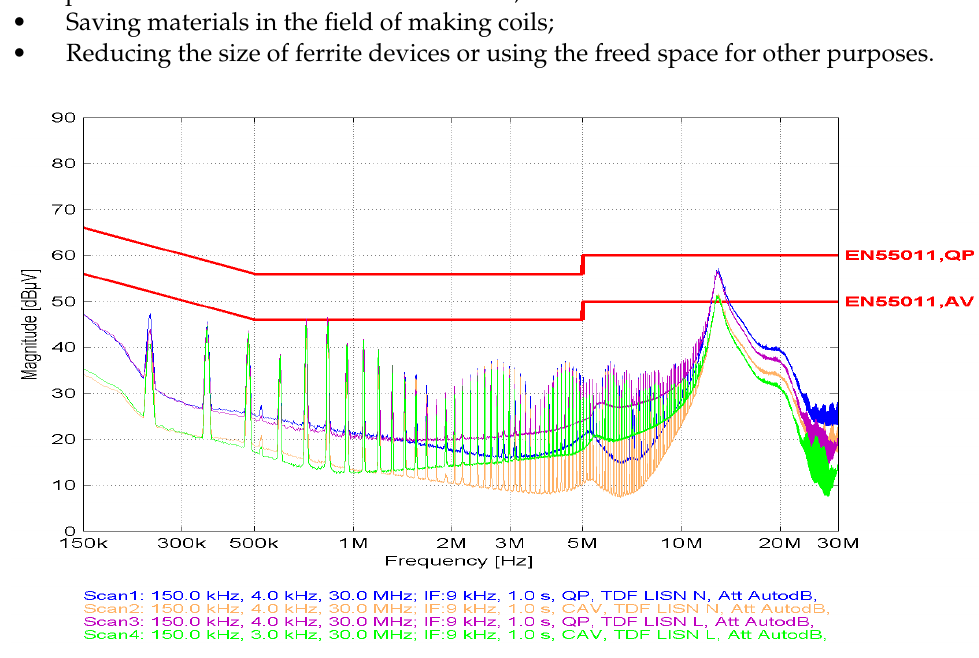
Figure 10. Attenuation level for ferrite No. 1 with the number of coils at 12